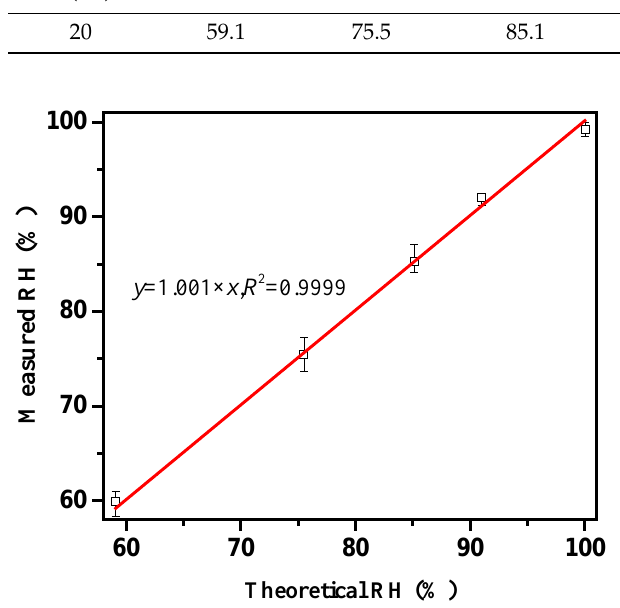
Table 3. Theoretical relative humidity of saturated salt solution (%).